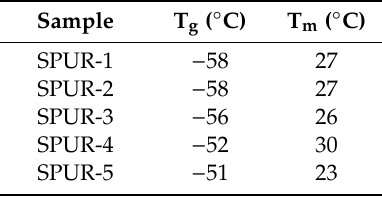
Table6. Theglass-transition(T g )andthemeltingtemperature(T g